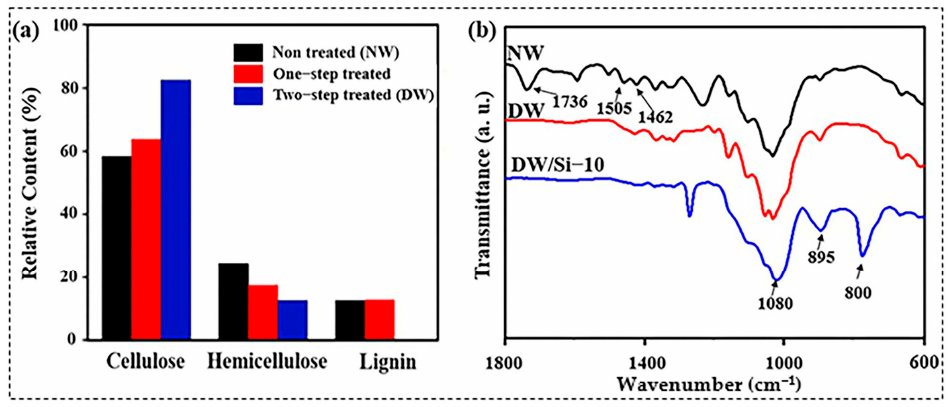
Figure 3. ( a ) Chemical composition and ( b ) FT − IR spectra of the samples.